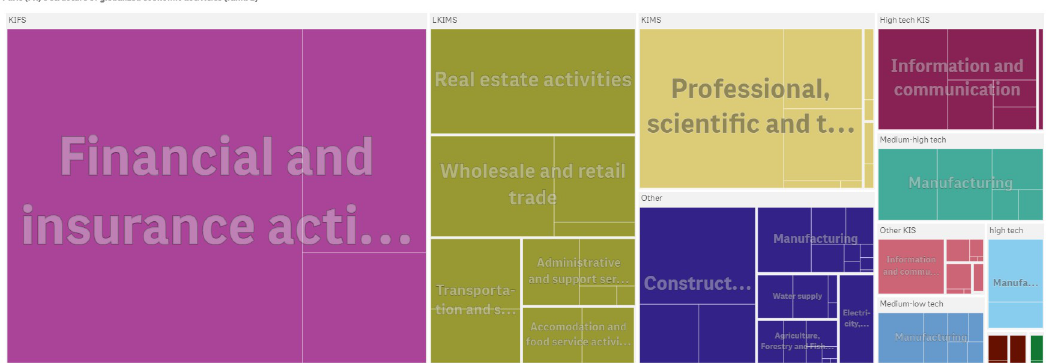
Fig 6. The economic activities of Paris (FR)’s firms with global presence. Paris ranks second in the economic complexity index of cities in 2010 (ECI: 5.314). The figure has been generated using Qlik Sense.